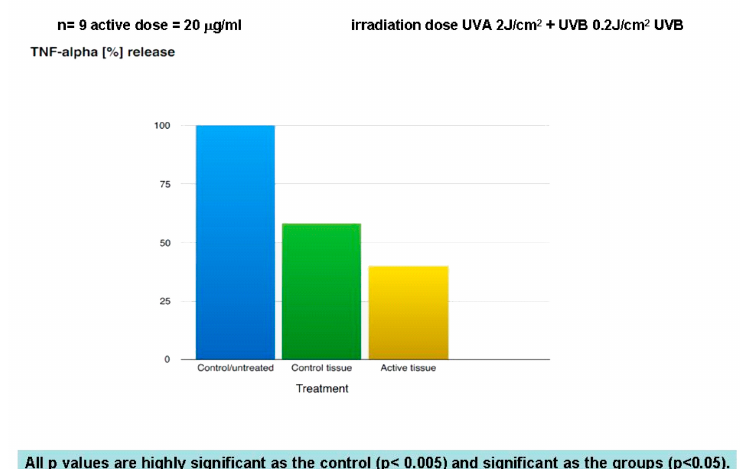
Figure 4. Anti-inflammatory effectiveness of the mask verified by the TNF-alpha release.